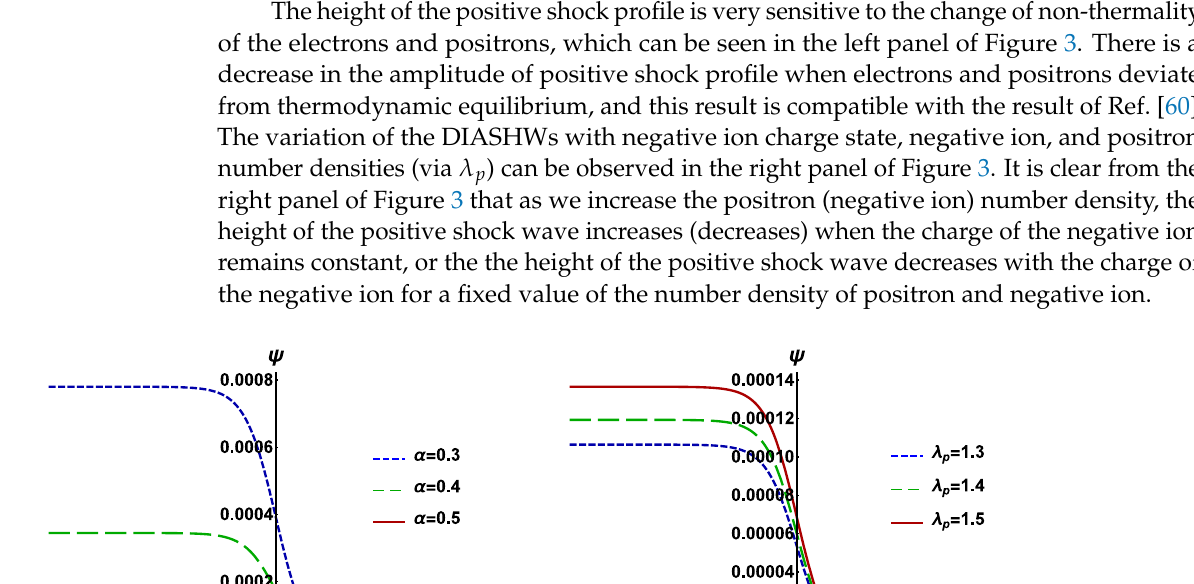
Figure 2. The variation of Ψ with ζ for different values of η under consideration of α 4 > α 4 c ( left panel ) and α 4 < α 4 c ( right panel ) along with α 1 = 1.5, α 2 = 0.05, α 3 = 0.03, λ p = 1.5, λ e = 1.7, λ d = 0.05, δ = 30 ◦ , α = 0.5, U 0 = 0.01, and V p ≡ V p + .